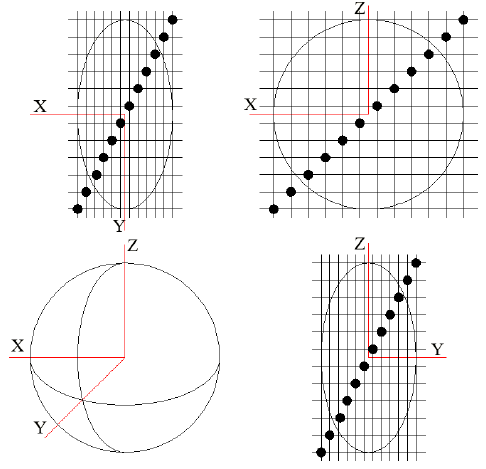
Figure 13. Machining points to be calculated.